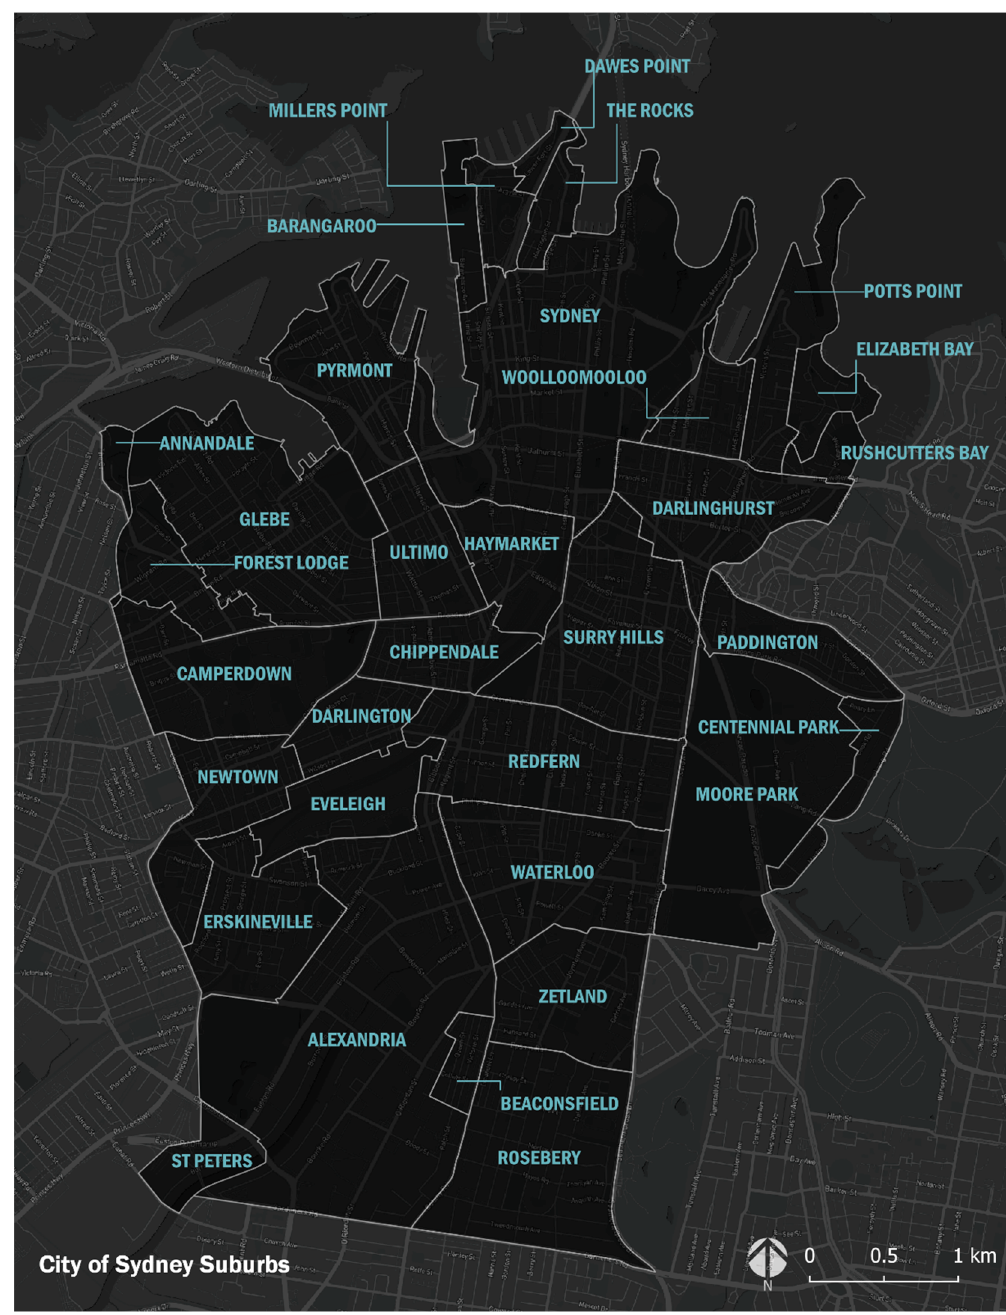
Figure 7. Study area and its suburbs.